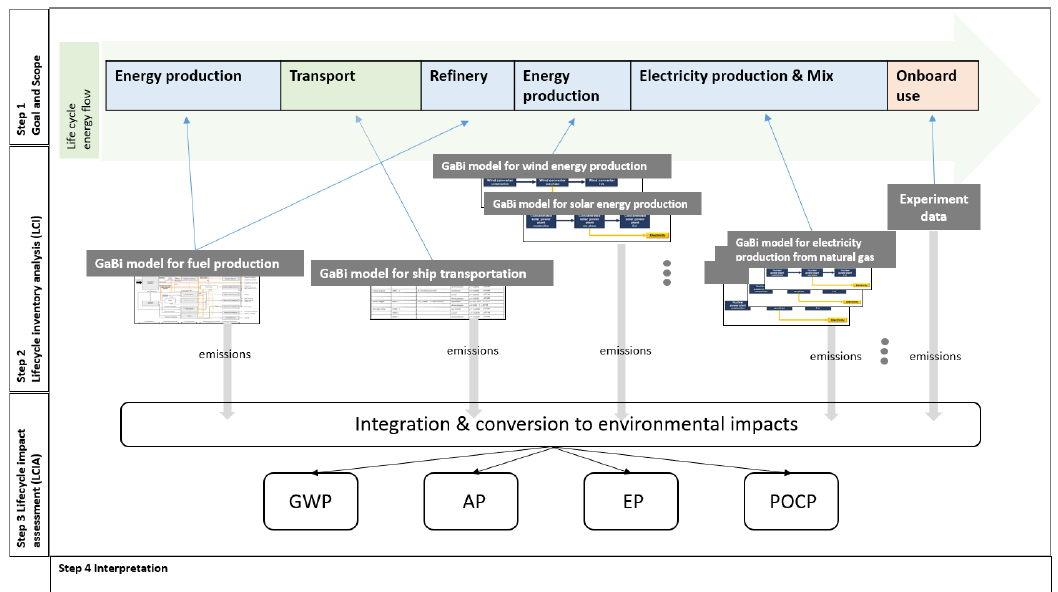
Figure 7. Overview of LCA for the case study.